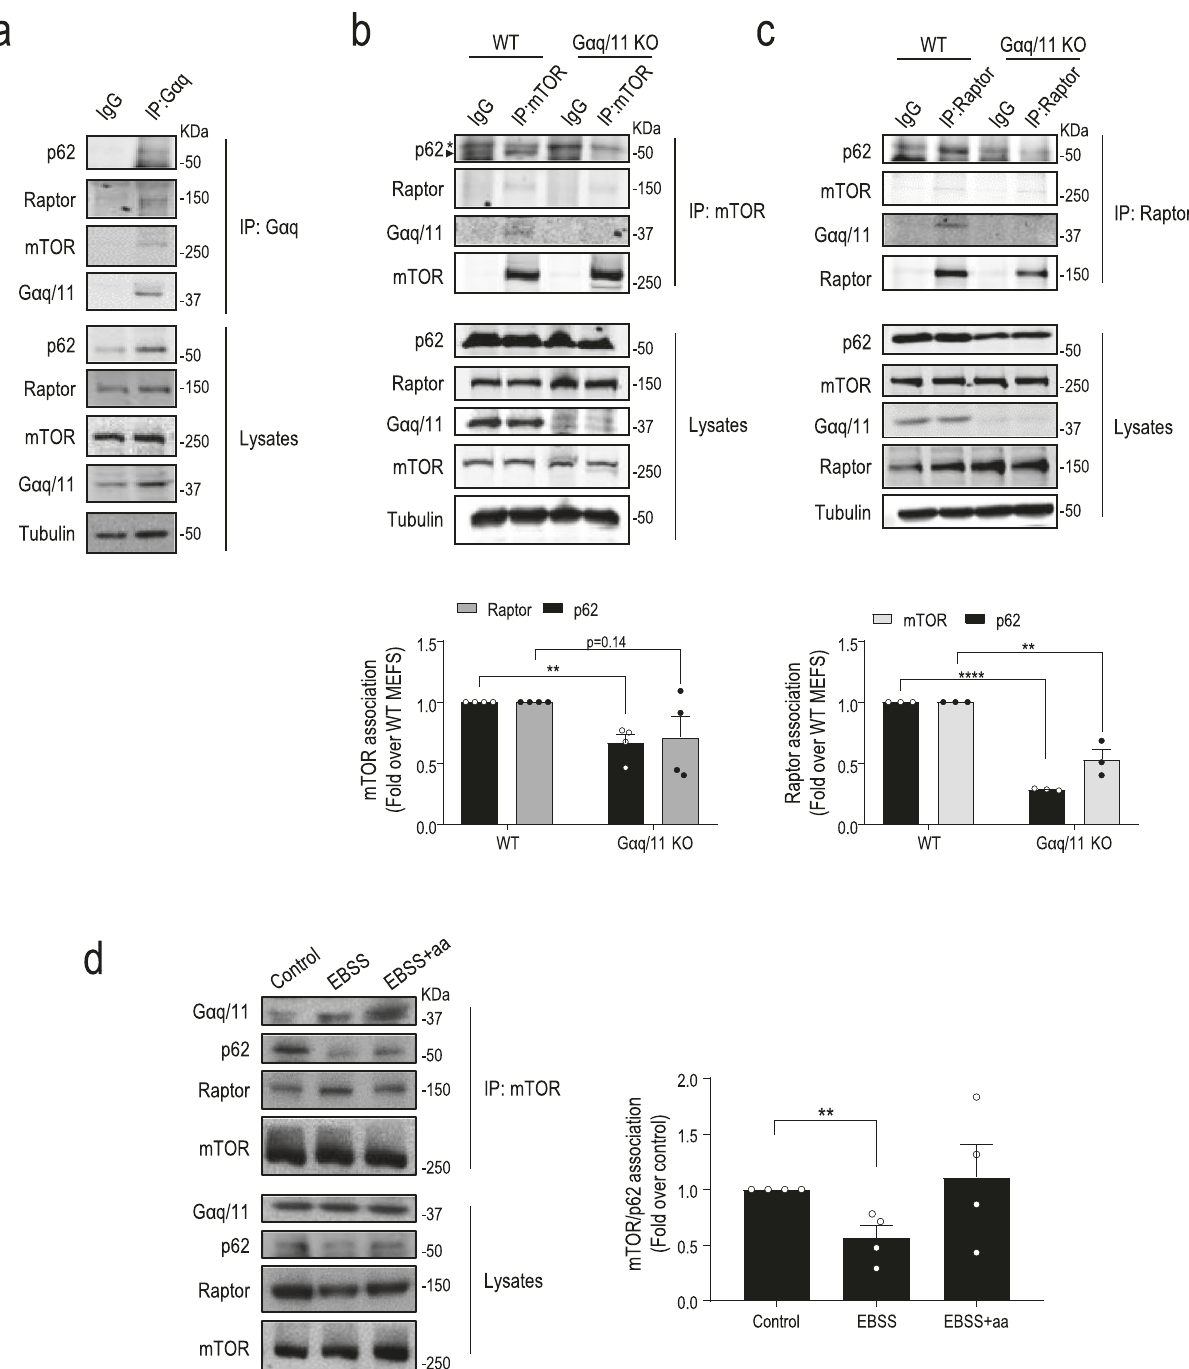
Fig. 5 G α q is part of the mTOR/p62/Raptor complex. Immunoprecipitation of endogenous G α q ( a ), mTOR ( b ), or Raptor ( c ) was performed in WT ( a ) or the indicated MEFs ( b , c ) under nutrient-suf fi ciency conditions (10% FBS). Blots are representative of three ( a , c ) and four ( b ) independent experiments. In b ( n = 4) and c ( n = 3), data (mean ± SEM of the indicated independent experiments) were normalized by total mTOR ( b ) or Raptor ( c ) and expressed as fold change of association with respect to the WT control condition. d Endogenous mTOR immunoprecipitation was performed as in panel b in WT MEFs treated with EBSS for 30 min and stimulated with a full amino acid mix for 15 min. Data (mean ± SEM of four independent experiments) were normalized by total mTOR and expressed as fold-change p62 association with mTOR with respect to the 10% FBS control condition. Statistical signi fi cance was analyzed using two-sided unpaired t -test. For all P values, ** P < 0.01, **** P < 0.0001. b WT vs G α q/11 KO (p62/mTOR association), P value = 0.0030. c WT vs. G α q/11 KO (p62/Raptor association), P value < 0.0001, and WT vs. G α q/11 KO (mTOR/Raptor association), P value = 0.0047. d Control vs. EBSS, P value = 0.0083. Source data are provided as a Source Data fi